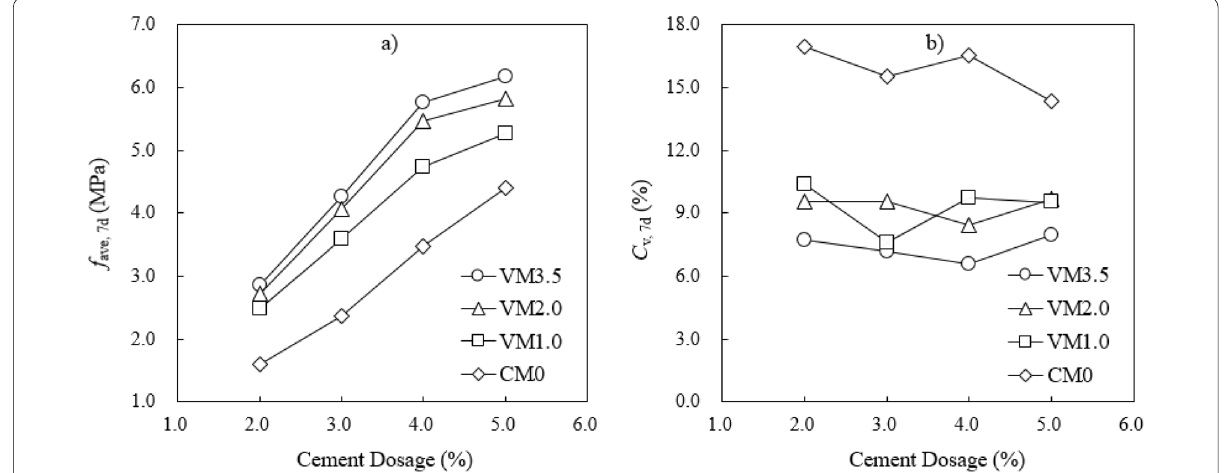
Fig. 6 7-Day UCS versus cement dosage under different mixing methods. a Average UCS; b coefficient of variation of strength.